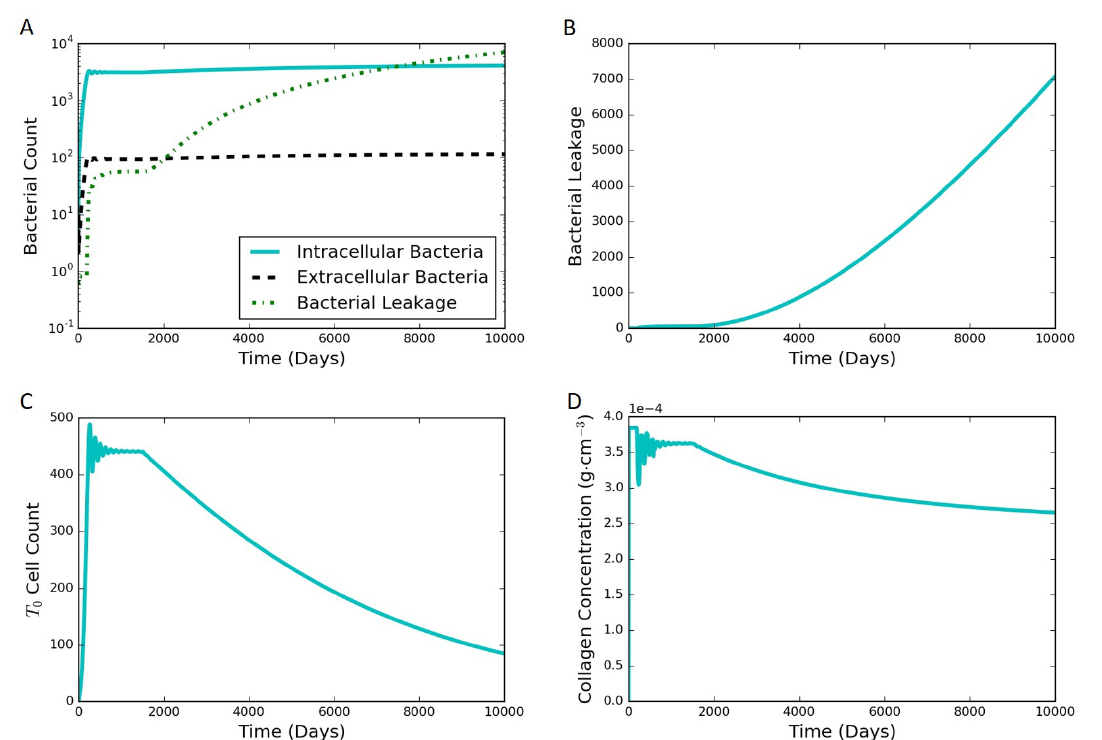
Figure 8. Simulation results for the in silico HIV co-infection experiment via T 0 cell depletion after 1500 days. The depletion results in a leaking state. ( A ) bacterial populations and cumulative bacterial leakage (log scale) vs. time; ( B ) cumulative bacterial leakage (linear scale) vs. time; ( C ) T 0 cell count (linear scale) vs. time; ( D ) concentration of collagen (linear scale) vs. time.